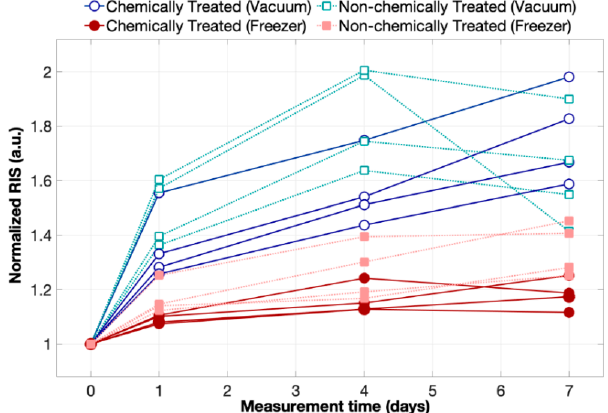
Figure 5. ESR signal peak-to-peak amplitude (App) changes with time in chemically and non-chemically treated samples stored at two di ff erent conditions (vacuum chamber and freezer). All experimental points from each experiment were normalized with regard to the first measurement data soon after the exposure to 20 Gy of 137 Cs γ